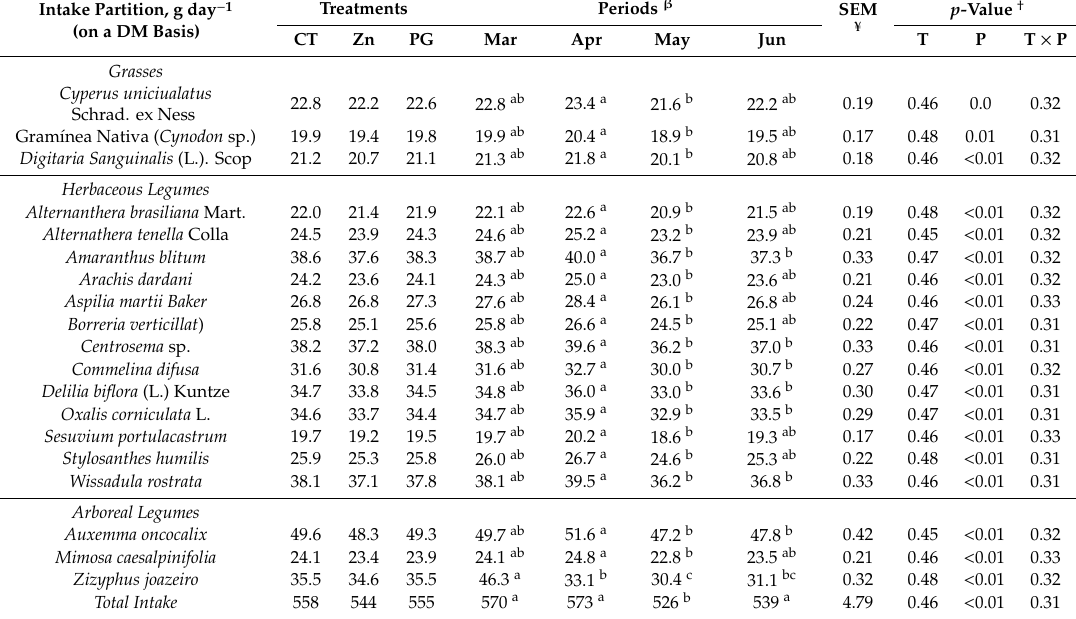
Table 7. E ff ects of zinc sulfate or propylene glycol supplementation on the pasture selection in sheep on Caatinga -native